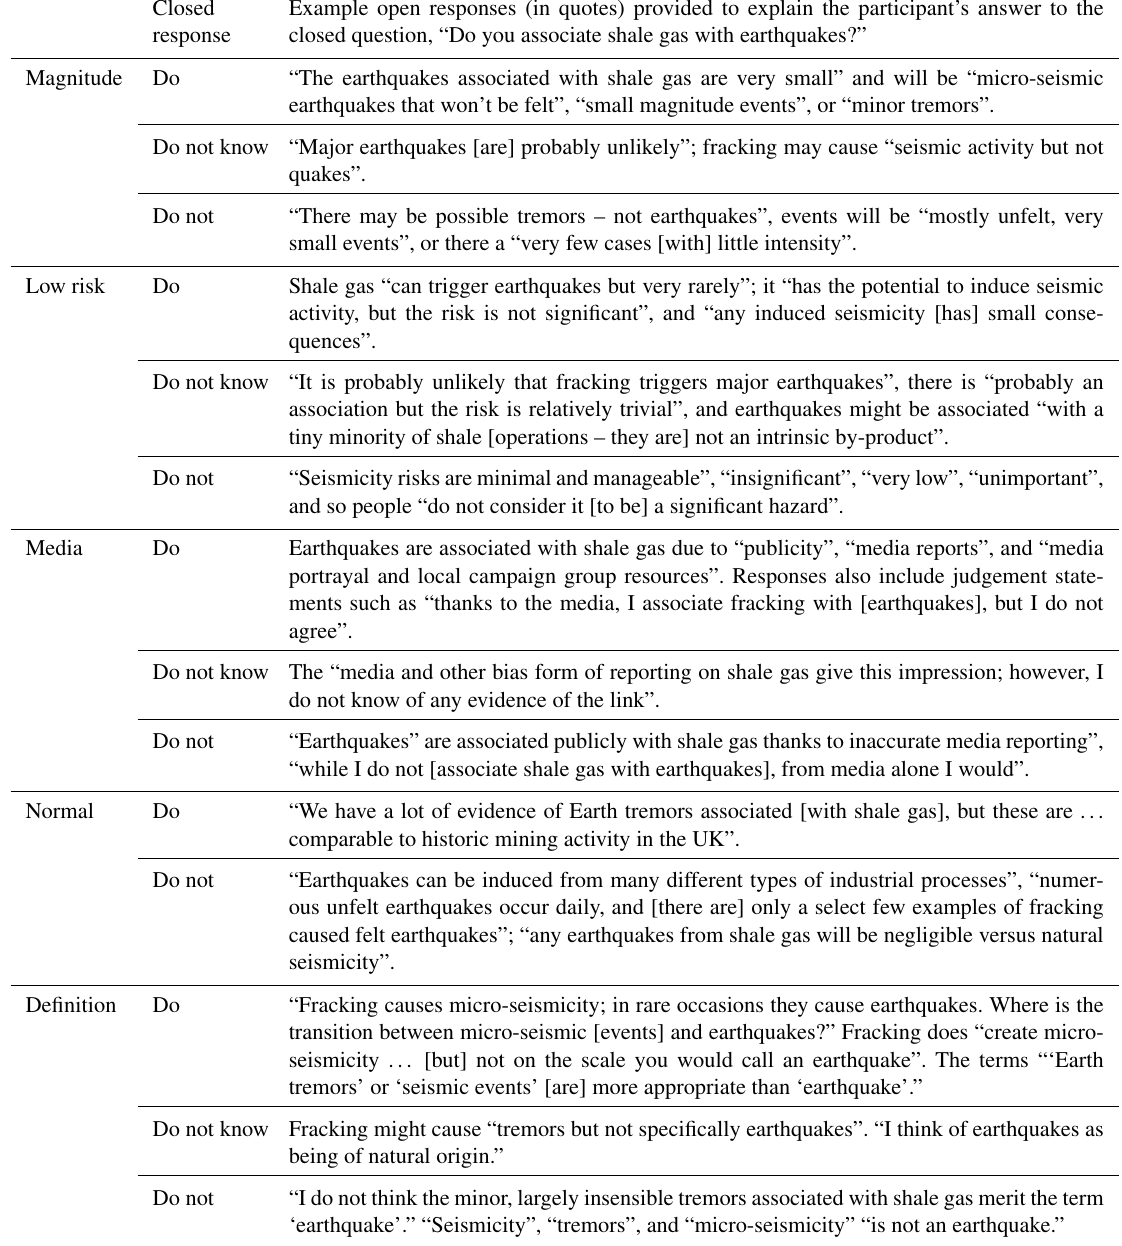
Table 7. Example of the open responses to illustrate how the most common codes are used to defend the range of participant responses to whether or not they associate shale gas with earthquakes. “Magnitude” is generally used to defend “do” and “do not” answers, “risks” is used for all responses, whereas “media” most often applies to “do” answers. “Normal” and “definition” codes tend to be applied to “do not”